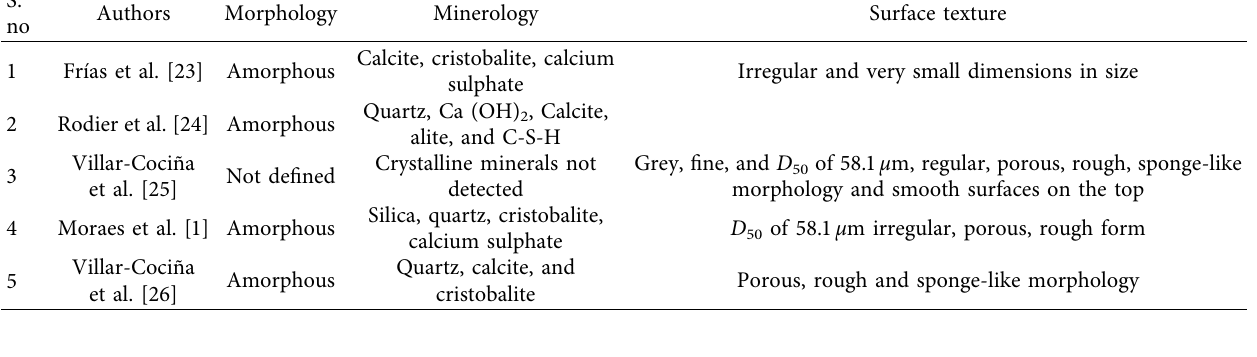
Table 8: Mineralogical and morphological behavior of bamboo leaves’ ashes.